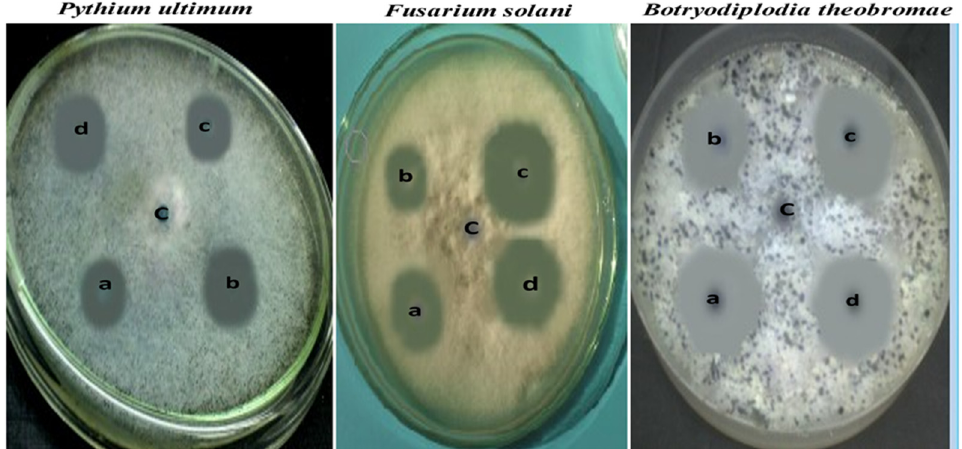
Figure 7. In vitro susceptibility of the three pathogenic fungi investigated in this study to the different cyanobacterial and algal strains using the well diffusion assay. The highest antifungal activities were obtained by Anabaena sp. ( a ), Oscillatoria nigro-viridis ( b ), and Dunaliella sp. ( c ), compared to the standard fungicide Rhizolex-T ( d ).